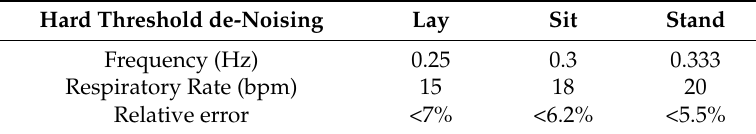
Table 1. Respiratory activity data under different